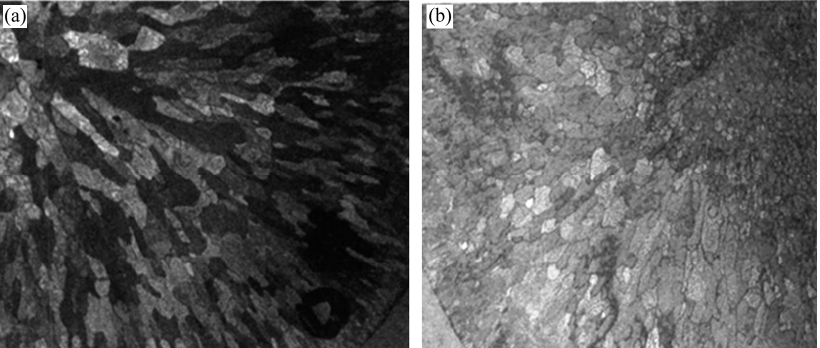
Figure 5. As-cast microstructure of an as-cast 430 ferrite stainless steel: ( a ) without RE, and ( b ) with 0.073% RE [47] , with permission of Journal of the Chinese Society of Rare Earths/Journal of the Chinese Rare Earth Society, 2006.